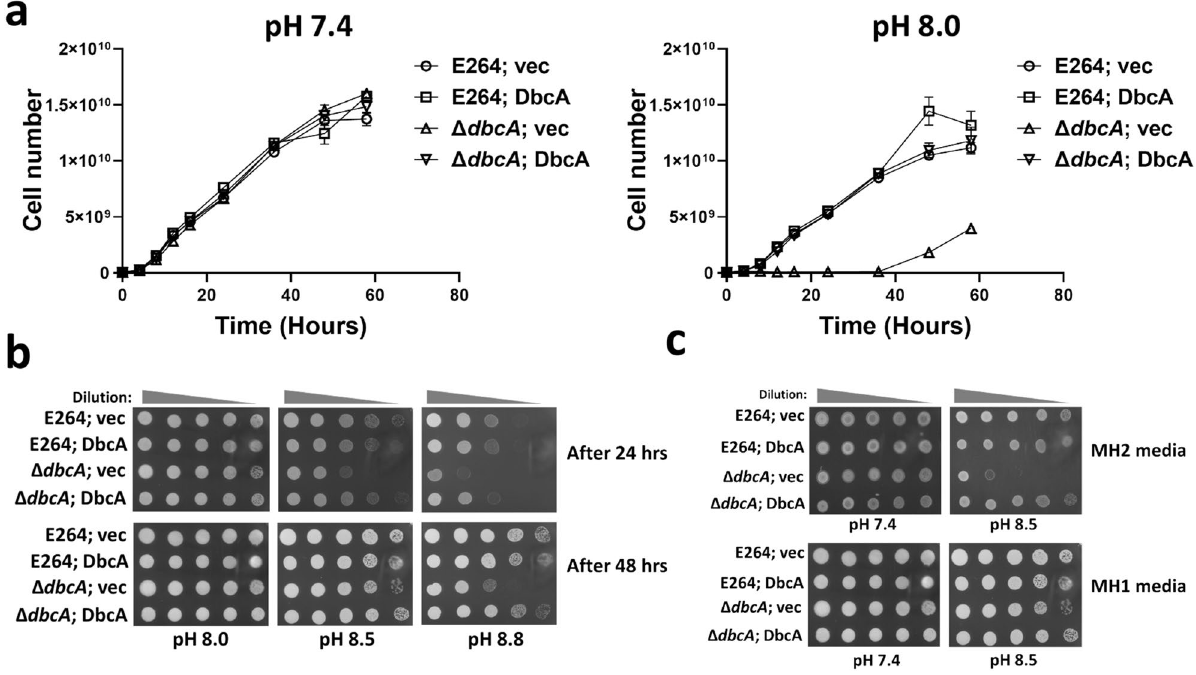
Figure 1. Alkaline pH sensitivity of B. thailandensis ∆ dbcA. ( a ) Growth rate of B. thailandensis strains (E264; vec, E264; DbcA, ∆ dbcA ; vec, and ∆ dbcA ; DbcA) at different times in Mueller Hinton broth (MH1) with 100 µg/ ml Tmp. The error bars indicate standard deviations of three biological replicates. ( b ) Spot assay of E264; vec, E264; DbcA, ∆ dbcA ; vec, and ∆ dbcA ; DbcA on MH1 agar media. 1:10 dilutions of indicated strains were spotted on NaOH adjusted MH1 media with 100 µg/ml Tmp and 0.001% rhamnose. Plates were analyzed after 24 or 48 h at 37 °C. ( c ) Comparison of alkaline pH sensitivity of B. thailandensis ∆ dbcA in MH2 with MH1 agar media. MH2 contains ~ 20 to 25 mg/l of calcium and ~ 10 to 12.5 mg/l of magnesium, whereas MH1 contains no added calcium and magnesium salts. The pH was adjusted by either HCl or NaOH. Plates were analyzed after 48 h of growth at 37